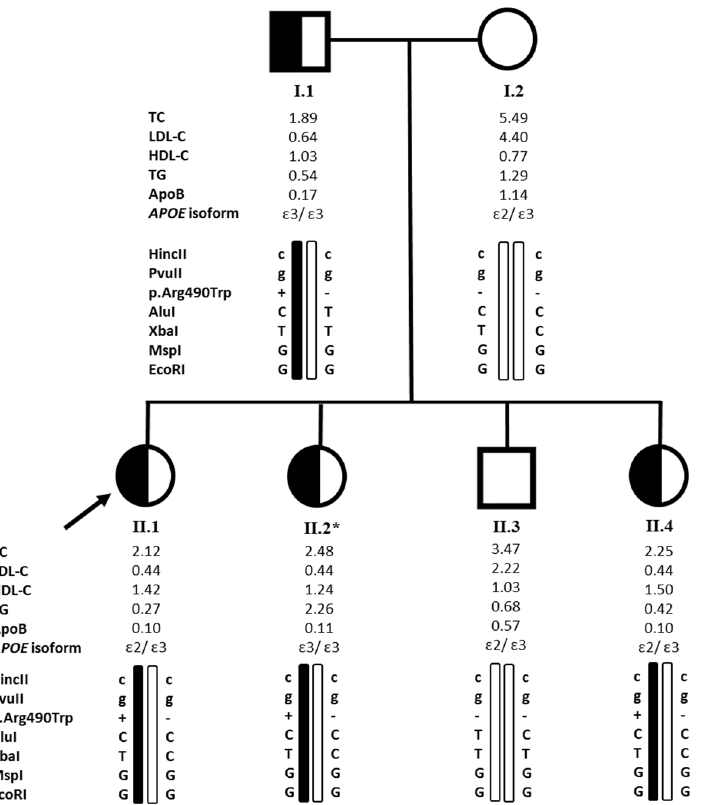
Figure 1. Pedigree of family 1 and haplotype analysis. The arrow indicates the proband. Half blackened symbols indicate heterozygous carriers of the p.(Arg490Trp) (p.(Arg463Trp), according to the original nomenclature) variant in the APOB gene and unblackened symbols indicate unaffected members. Filled bars indicate the allele carrying the mutation. The +/ − sign indicates that the individual is heterozygous for the p.(Arg490Trp) variant and the − / − sign indicates that the individual does not carry the variant. APOE isoforms are also presented. TC, LDL-C, HDL-C, TG levels are given in mmol/L and ApoB levels are given in g/L. HDL-C: high-density lipoprotein cholesterol, LDL-C: low-density lipoprotein cholesterol, TC: total cholesterol, TG: triglycerides. The * sign indicates that the individual was not fasting when the blood sample was collected.